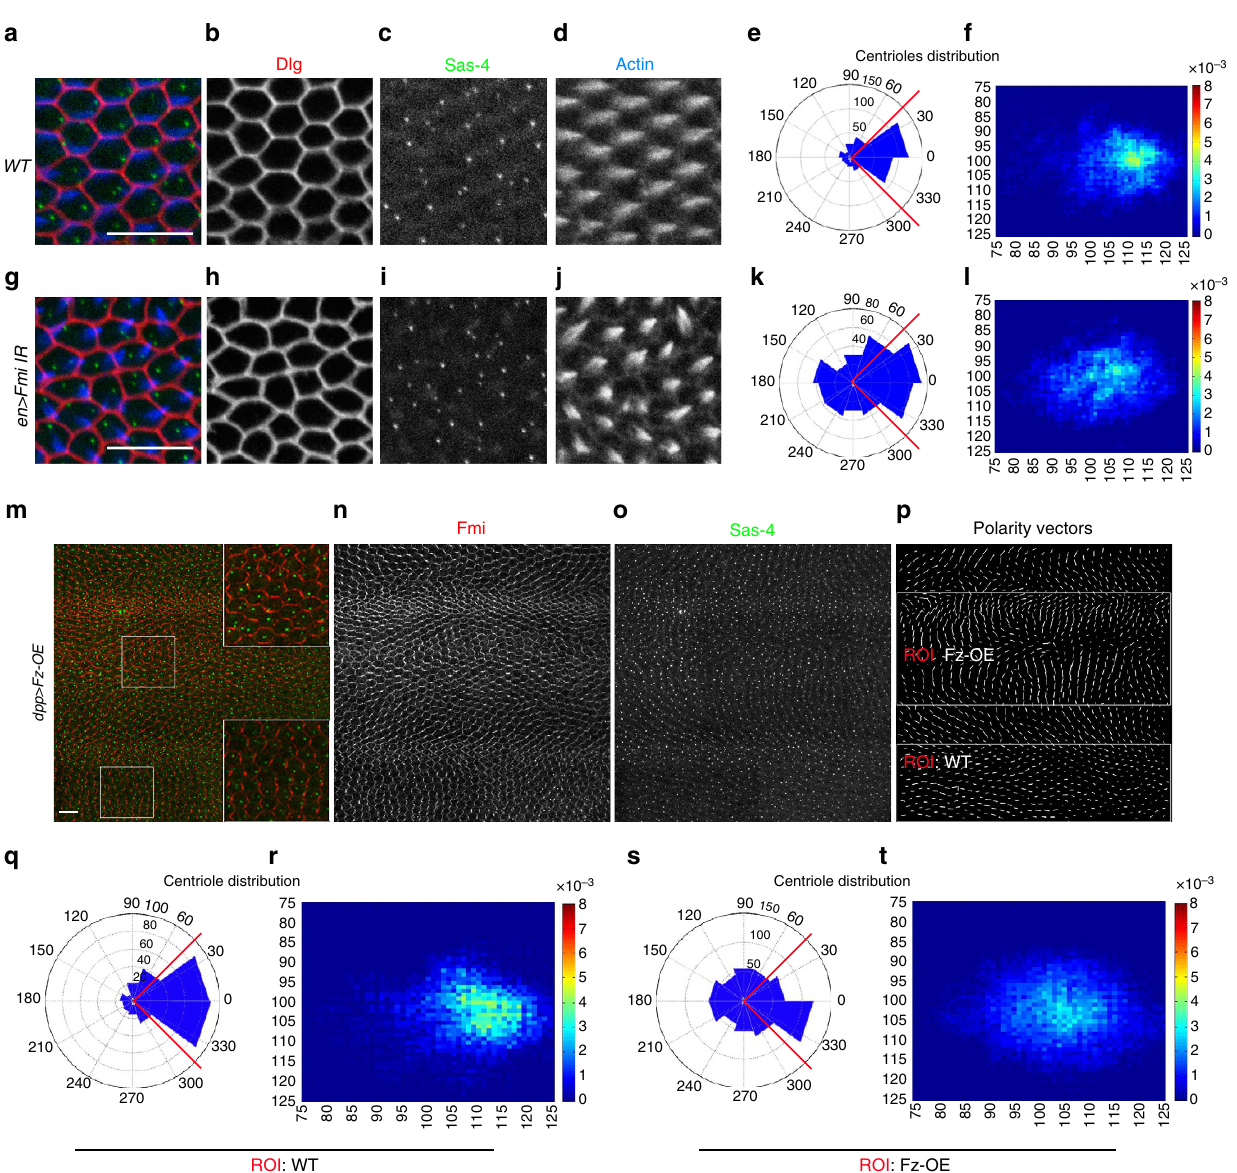
Figure 2 | Centriole position is affected by PCP signalling. ( a – l ) Fmi LOF, using en- driven fmi-IR knockdown affects centriole localization; ( a , g ) Dlg: red, cell outline; Sas4: green, centriole; actin (phalloidin): blue; and respective monochromes in a – d , h – j . Centrioles within cells in the en 4 fmi-IR area ( g ) are less polarized and are distributed more centrally, quantified in e – f and k – l , respectively. ( m – t ) Fz gain-of-function (GOF; see Methods), causes Fmi depolarization (see polarity vectors in p ), and defects in centriole distribution (Fmi in red, monochrome in n ; Sas4 in green, monochrome in o ). Fz overexpressing cells have central distribution of centrioles (quantified in s – t ; see also ROI: Fz-OE in p ), as compared with WT areas of dpp 4 Fz-OE wings (quantified in h , i ; see ROI: WT in p ). Scale bar, 10 m m. Statistical analyses: centriole rosette diagrams, e versus k : P o 0.0001; q versus s : P o 0.0001 ( w 2